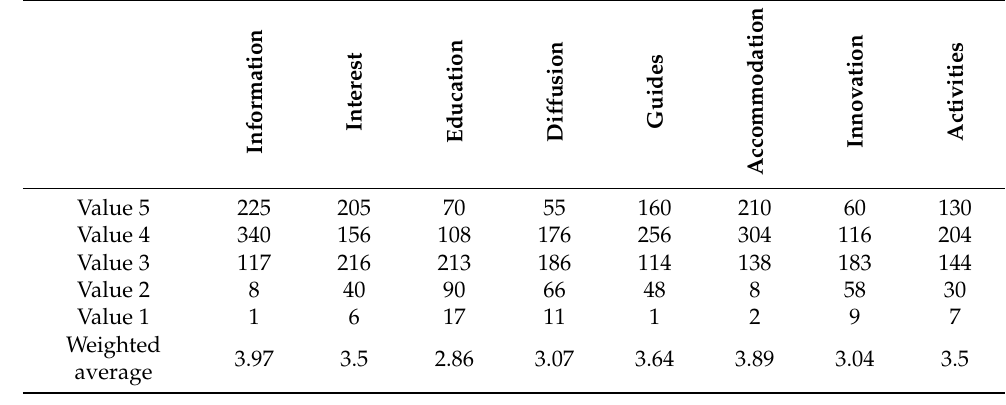
Table 11. Rating criteria according to